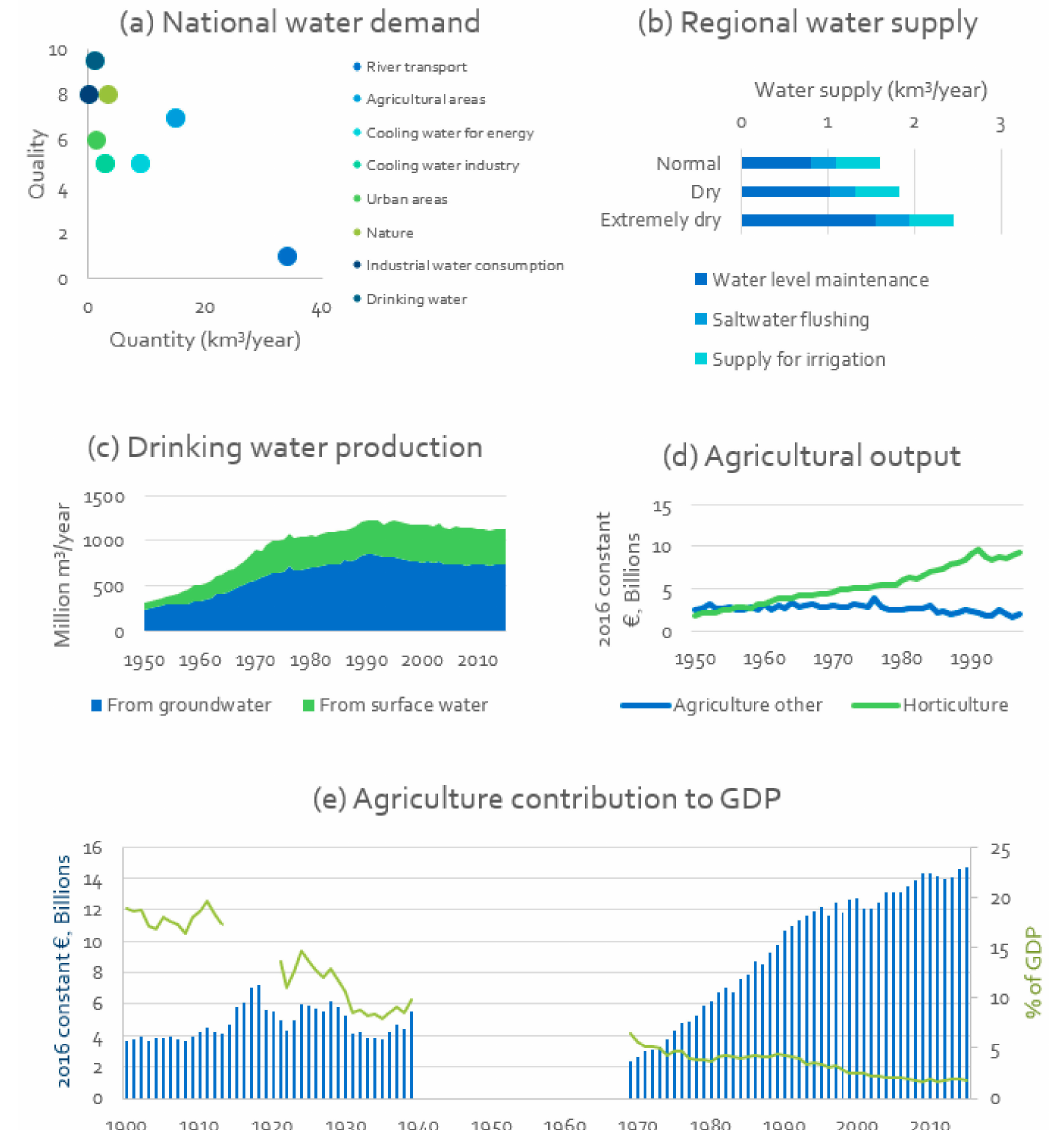
Figure 5. ( a ) National water demand by usage, with water quality ( Y -axis) as a relative aggregate score (10 = highest) [49]; ( b ) Supply to regional water networks by purpose; ( c ) Trend in drinking water demand, [54]; ( d ) Horticultural and other agricultural (without horticulture and livestock) output [55]; ( e ) Agricultural Value Added in 2016 constant Euro (bars, left scale) and as percentage of Gross Domestic Product (GDP) (line; right scale). Agriculture includes fisheries. Data sources: 1900–1940 [55]; 1968–2016 World Bank and OECD [56]; conversion historic value in Guilder to 2016 Euro using